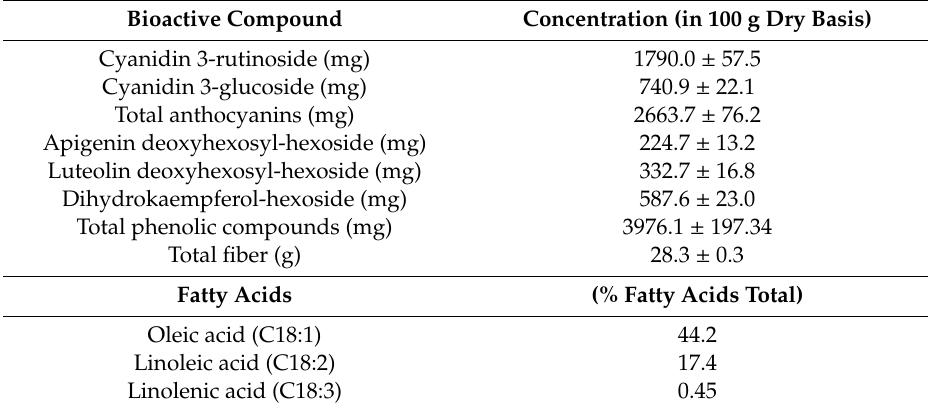
Table 5. The main bioactive compounds and fatty acids detected in juçara pulp powder. Bioactive